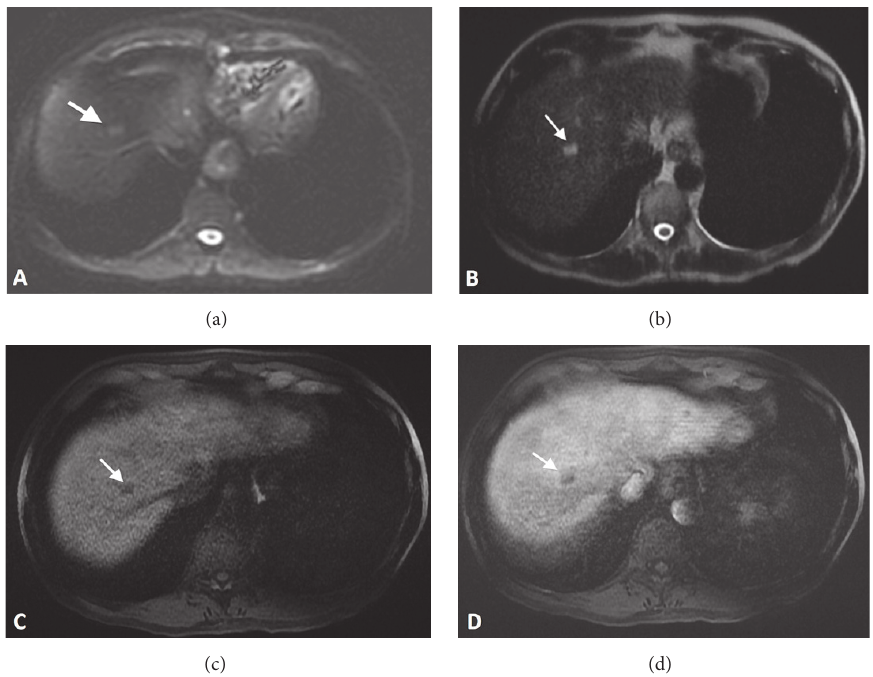
Figure 2: Four axial magnetic resonance images through the liver: (a) diffusion weighted sequence with hyperintense signal in segment 8 lesion showing restricted diffusion, (b) T2-weighted sequence with hyperintense signal within segment 8 lesion, (c) precontrast T1-weighted sequence showing hypointense signal compared to liver parenchyma in segment 8 lesion, and (d) arterial phase postcontrast T1-weighted sequence showing rim enhancement of segment 8 lesion.